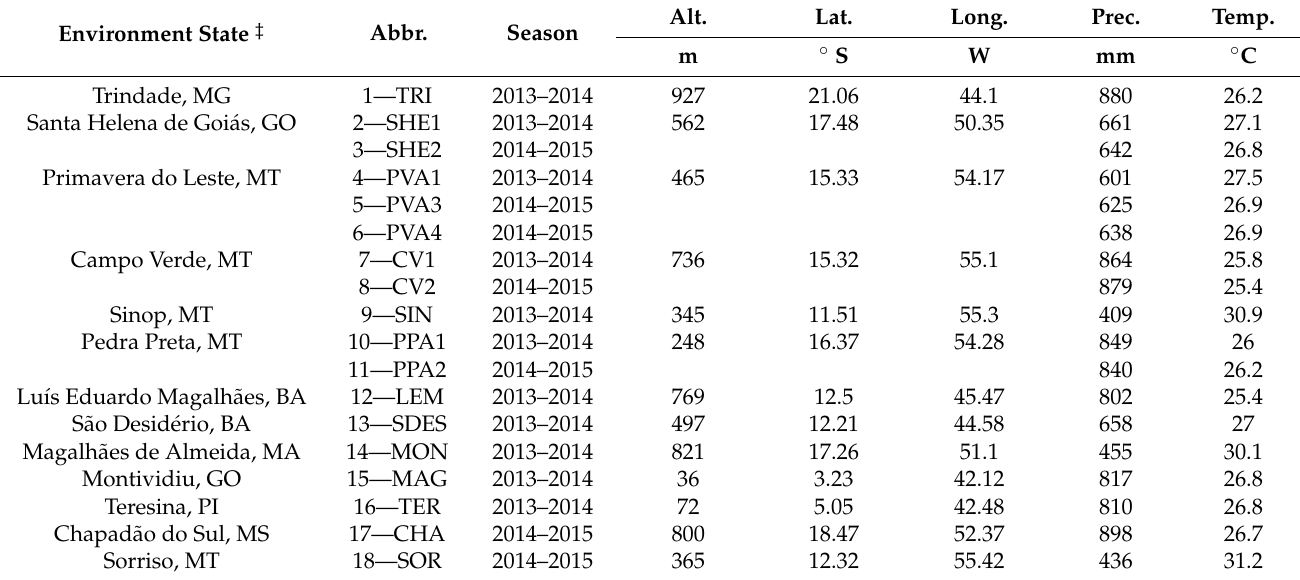
Table 1. Abbreviations of genotypes and description of environments regarding geographic coordinates and climatic characteristics of cotton variety test sites † evaluated for environmental impact in the Brazilian Cerrado. Environment State ‡